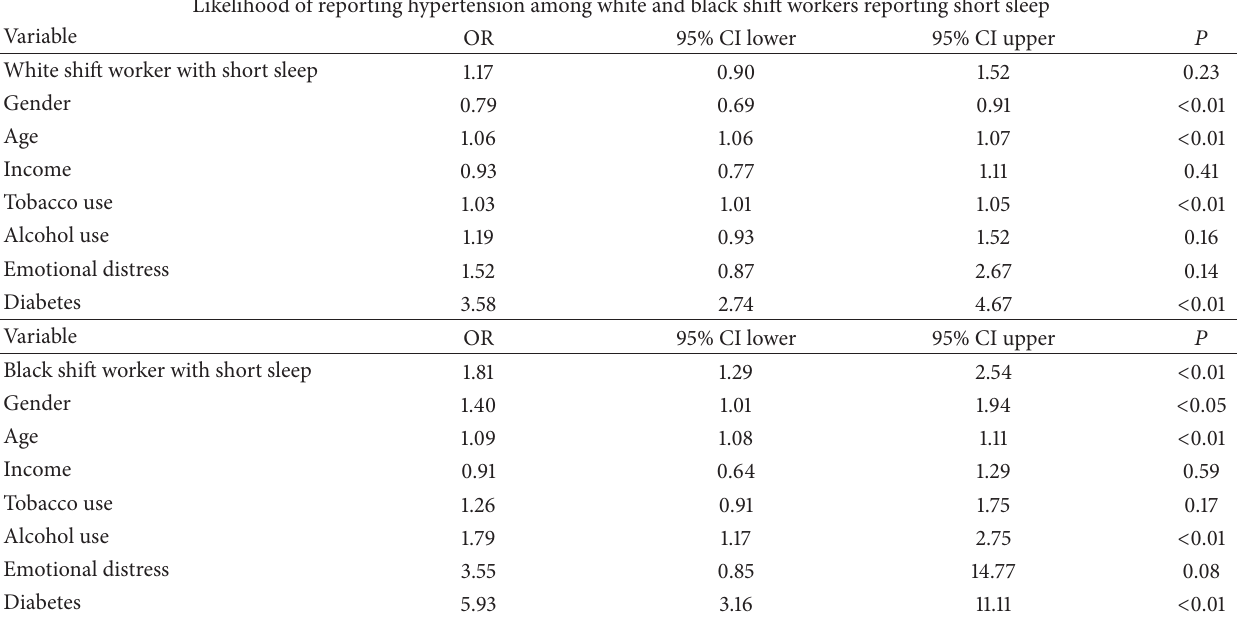
Table 4: Logistic regression analysis indicating adjusted odds ratios (OR) and confidence intervals (CI) for hypertension among white (top pane) and black (bottom pane) shift workers reporting short sleep